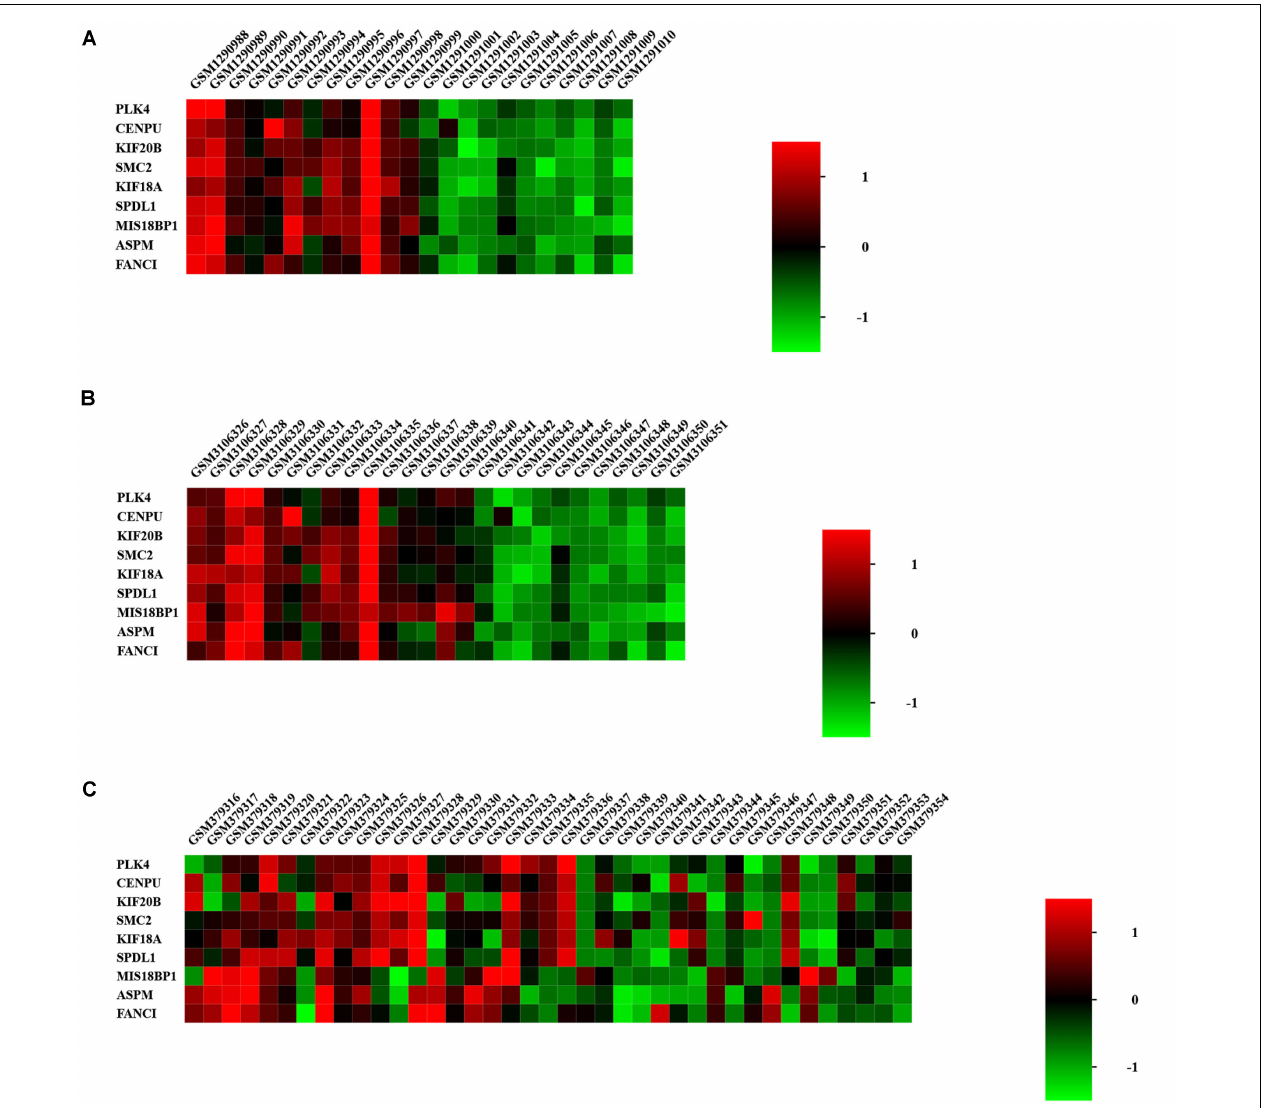
FIGURE 7 | Heatmap of hub genes in GSE53408 (A) , GSE113439 (B) , and GSE15197 (C) . The nine identified hub genes showed elevated expression in the PAH group.